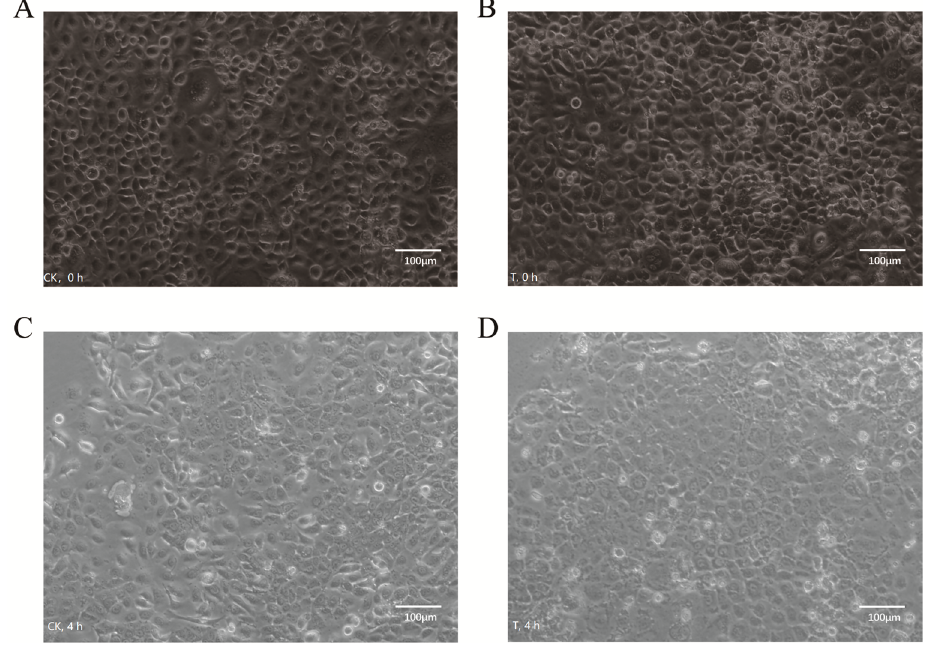
Figure 2. Image analysis of the cellular changes in goat bronchial epithelial cells incubated with P. multocida for 4 h. ( A , B ) Morphology of cells in the CK (Panel A ) and T (Panel B ) group at 0 h. ( C , D ) Morphology of cells in the CK (Panel C ) and P. multocida -infected (Panel D ) group at 4 h.